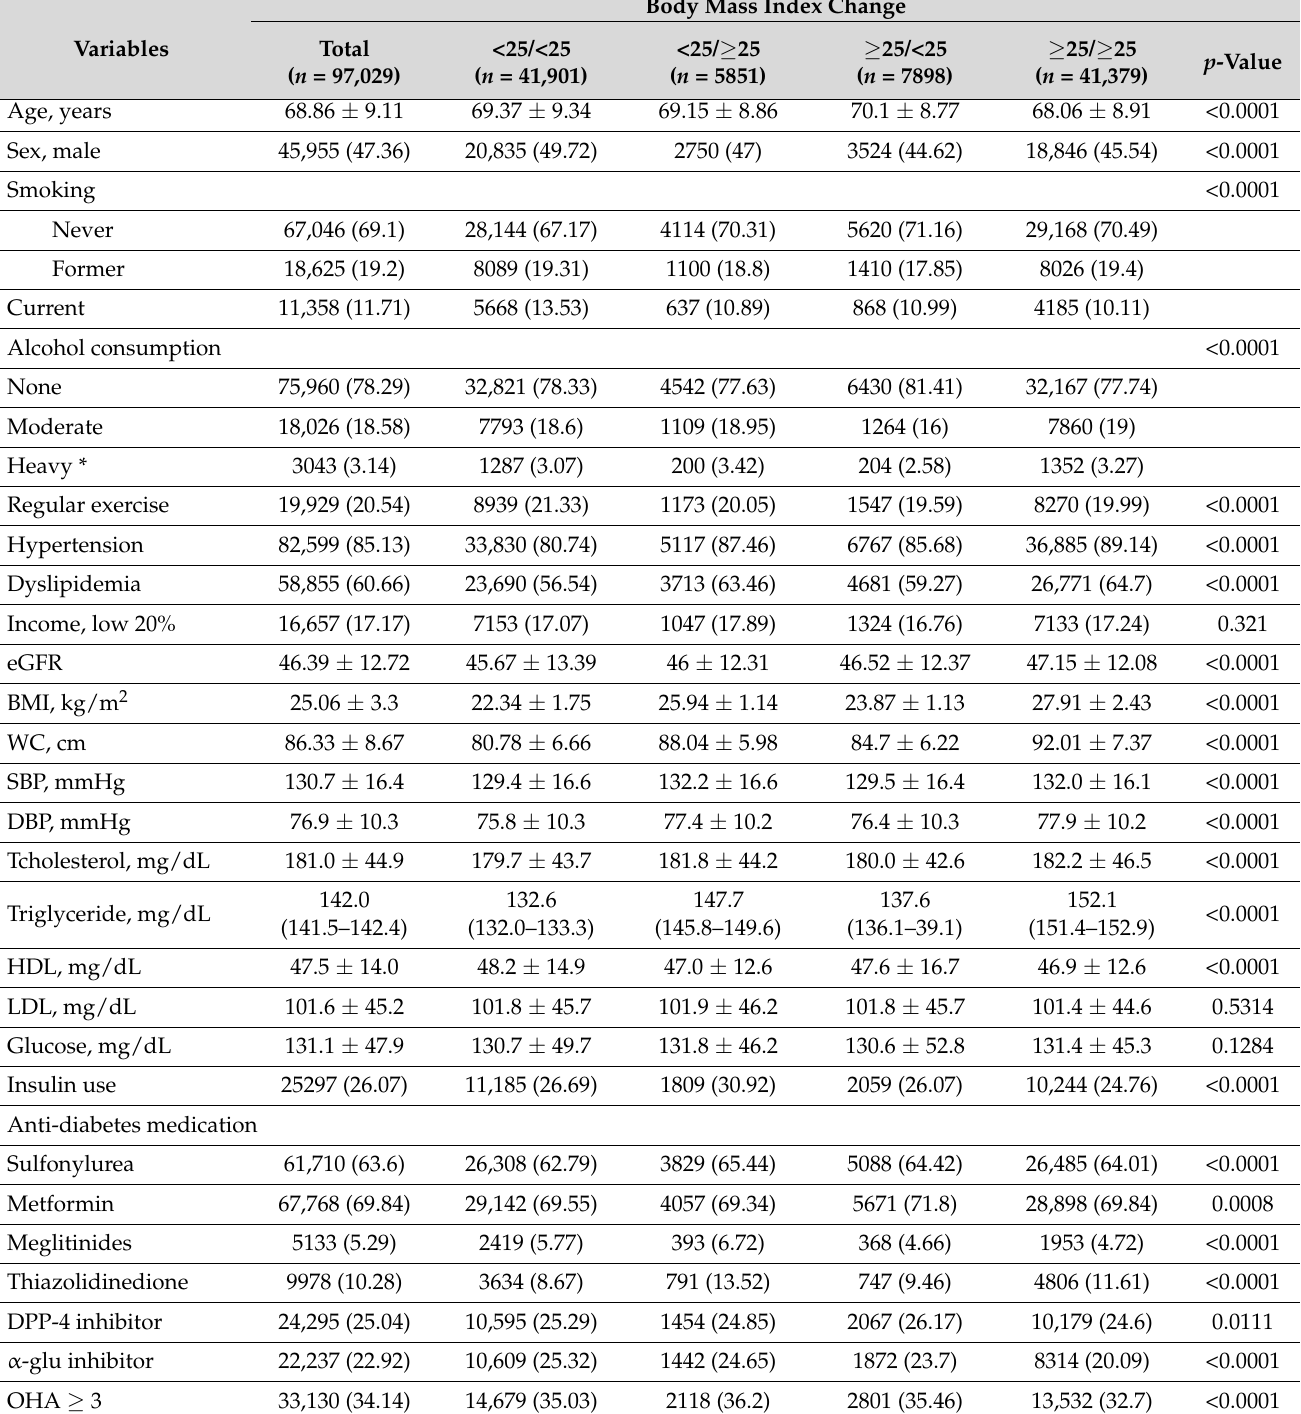
Table 1. Baseline characteristics of patients according to body mass index